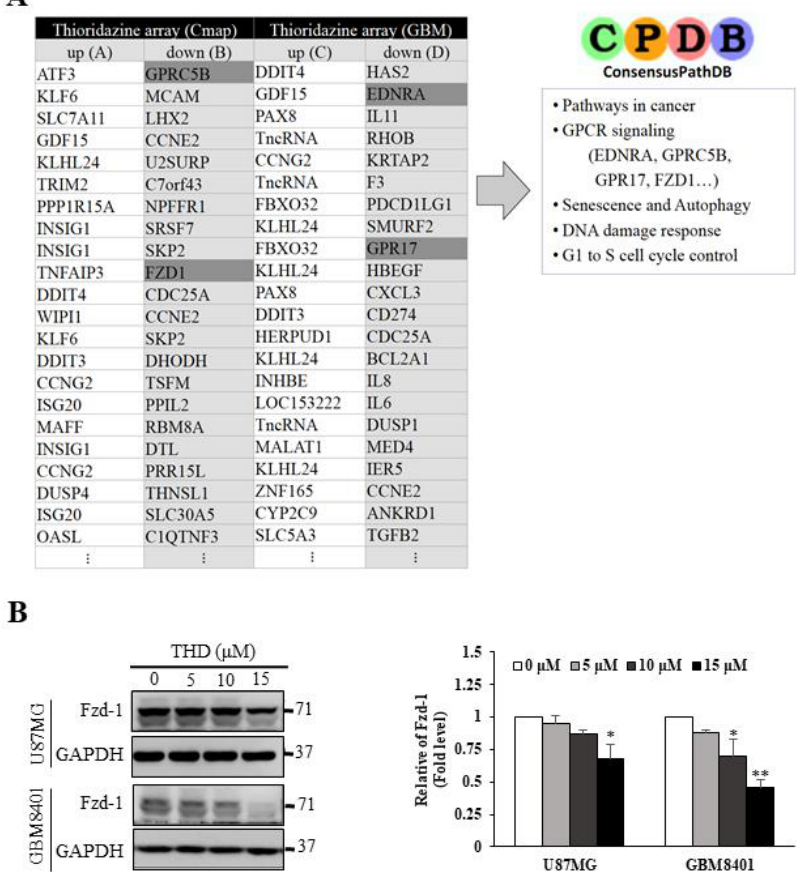
Figure 4. GPCRs targets of THD. ( A ) Two databases were used to identify possible pathways involved in THD-induced autophagy and apoptosis by using the ConsensusPathDB pathway analyzer. The most significant pathways include cancer-related pathways, G-protein-coupled protein signaling, senescence and autophagy, DNA damage response, and G1 to S cell cycle control; ( B ) Candidate protein Fzd1 was validated on GBM8401 and U87MG with 24-h treatment with 5, 10, or 15 µM THD. GAPDH was used as an internal control. Bar graphs represent the mean of triplicates ± SD. * p < 0.05, ** p < 0.01, compared with the control group.